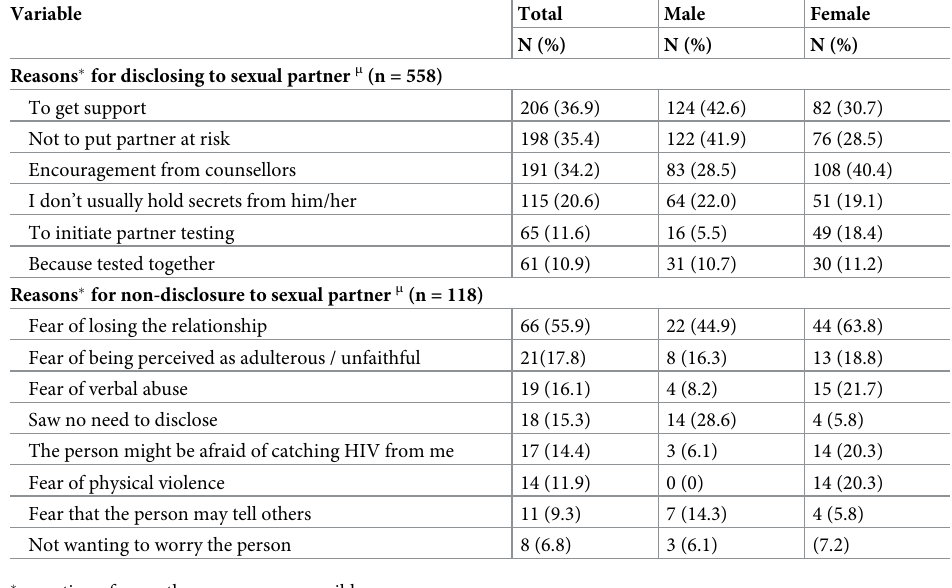
Table 4. Reasons for disclosure / non-disclosure to most recent sexual partner by